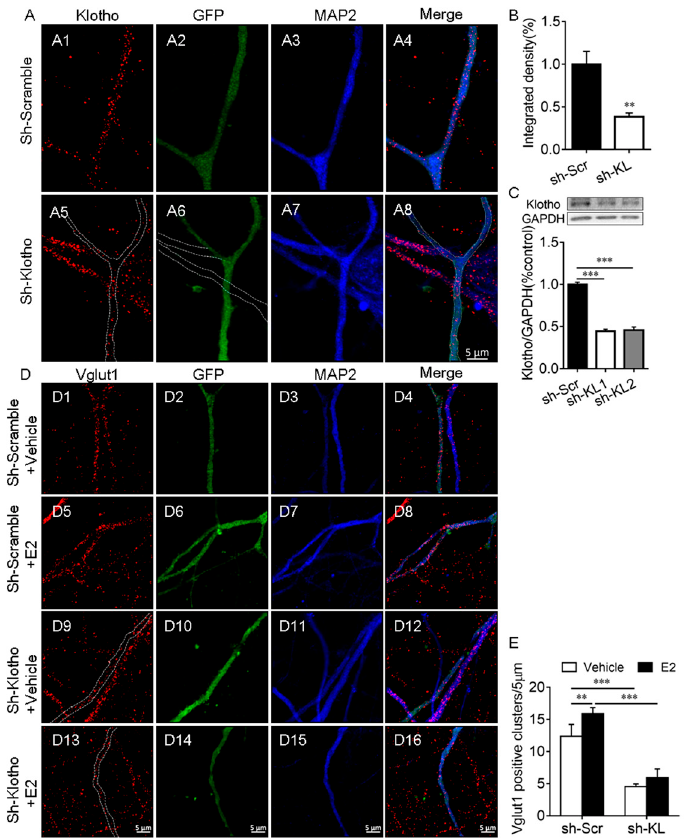
Figure 2. Klotho played an essential role in the E2-mediated increase in the number of Vglut1-positive clusters in hippocampal neurons. Primary cultured hippocampal neurons were transfected with a vector encoding scrambled control shRNA (sh-Scr, ( A1 – A4 )) or Klotho shRNA (sh-KL, ( A5 – A8 )) at Div10, and the neurons were fixed for double-immunostaining with anti-KL (red) and anti-MAP2 (blue) antibodies at Div14. The dashed lines in ( A6 ) show the dendrites of the non-transfected neuron, which did not express Klotho shRNA-GFP ( A ). Quantification of KL expression in cultured hippocampal neurons ( B ). Two different Klotho shRNAs, sh-KL #1 and sh-KL# 2, were designed. Vectors encoding sh-Scr and sh-KL were introduced into the hippocampal neurons by electroporation at the time of plating, and the Western blot result ( C ) showed that the expression of shRNA #1 and #2 reduces klotho (130 kDa) expression effectively. We used sh-KL #1 in subsequent experiments. Cultured hippocampal neurons were transfected with a vector encoding sh-Scr ( D1 – D8 ) and sh-KL ( D9 – D16 ) at Div10, and the cultures at Div13 were treated with the vehicle ( D1 – D4 , D9 – D12 ) or 10 nM E2 ( D5 – D8 , D13 – D16 ) for 48 h before fixing for double-immunostaining with antibodies specific to Vglut1 (red) and MAP2 (blue; D ). Quantification of Vglut1-positive clusters ( E ). One-way and two-way ANOVA followed by Tukey’s test. Data are shown as the mean ± SEM. ** p < 0.01, *** p <